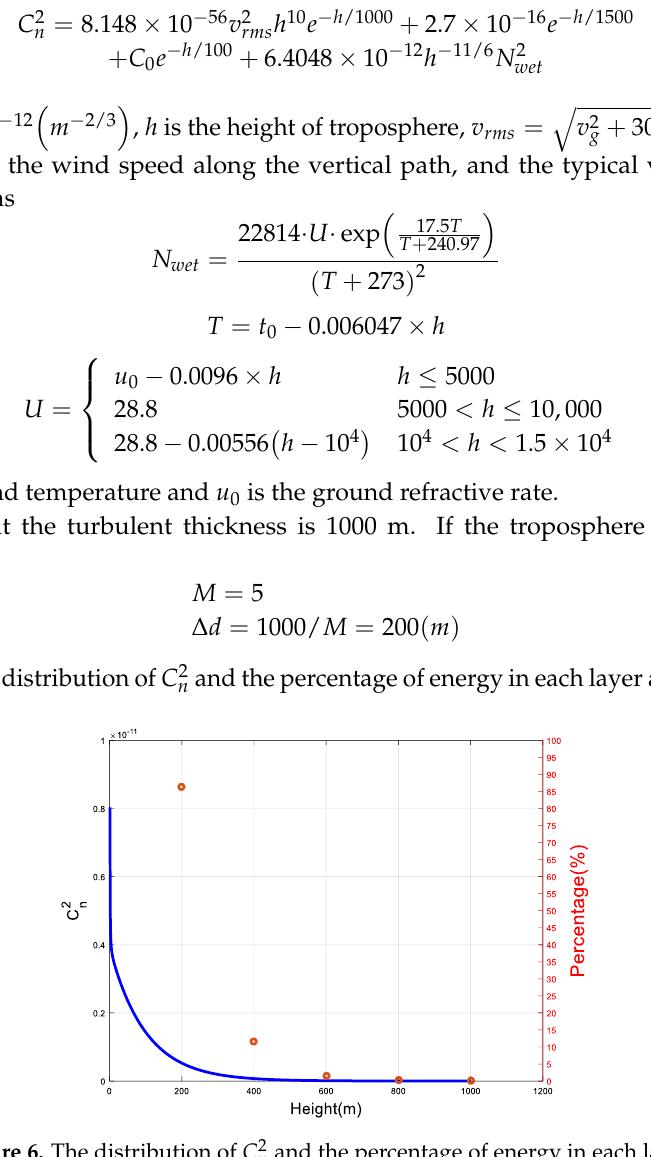
Figure 6. The distribution of C 2 n and the percentage of energy in each layer.